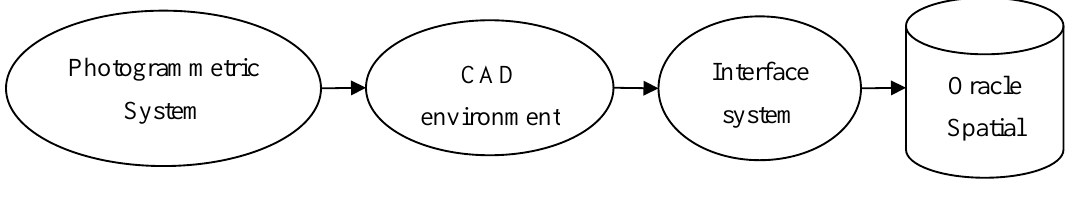
Figure 1. CAD environment as an interface for receiving data points sent from photogrammetric